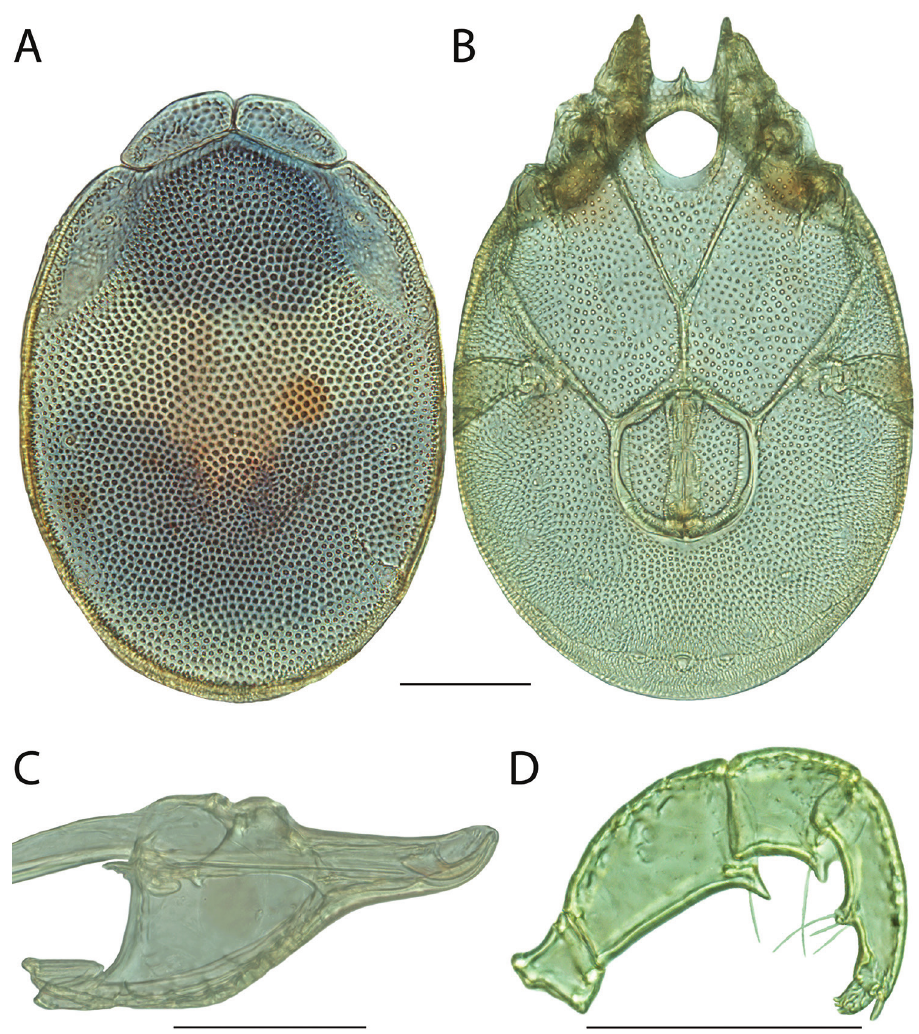
Figure 233. Torrenticola sellersorum sp. n. male: A dorsal plates B venter (legs removed) C subcapitulum D pedipalp (setae not accurately depicted). Scale = 100